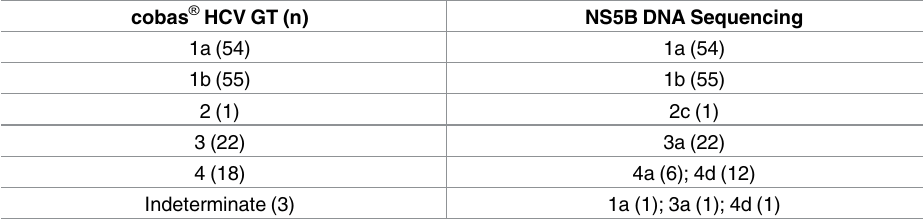
Table 1. HCV genotyping and subtyping results using cobas ® HCV GT and NS5B